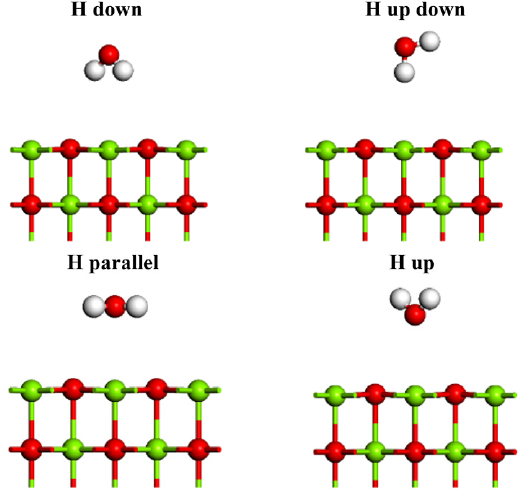
the MgO (100) plane, a large number of possible adsorption models can be established. The water molecules are placed at a distance of 3 Å from the MgO (100) plane.